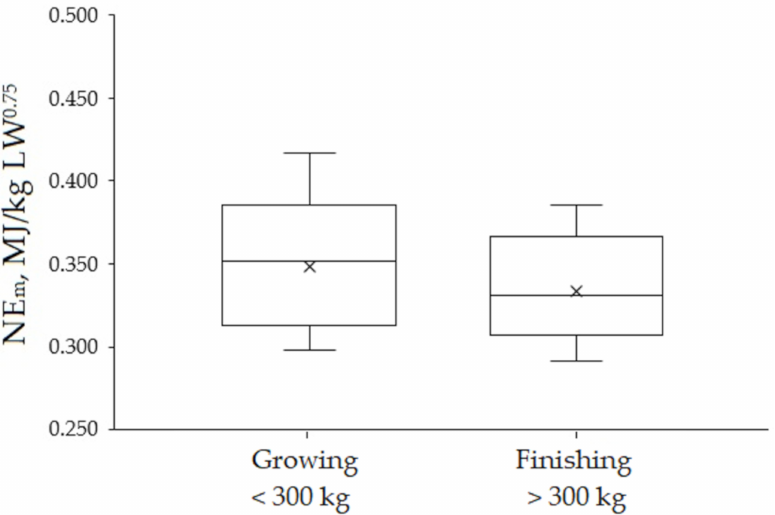
Figure 2. Boxplots of energy requirements for maintenance (NE m ) summarizing data from studies conducted with Zebu and crossbred cattle in Brazilian conditions. The values reported in the following studies were taken for obtaining this plot: Growing: [42–48]; Finishing: